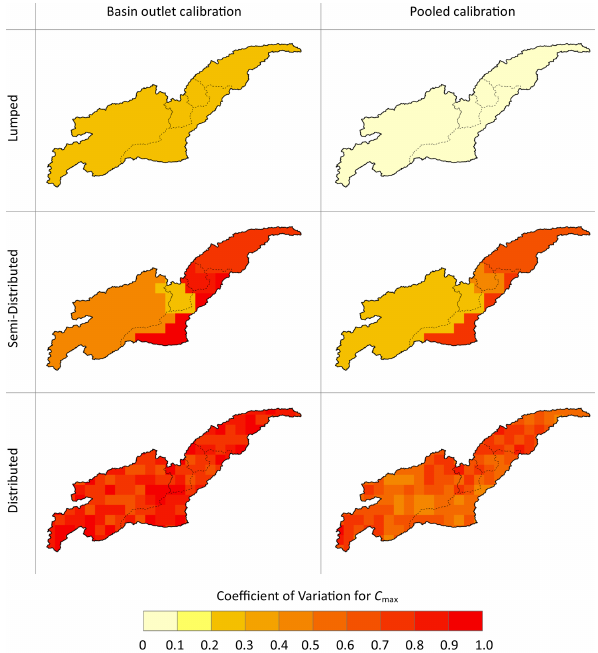
Figure 9. Coefficient of variation (CV) of 50 optimal values of C max (parameter for the soil moisture accounting module in the HYMOD_DS) from the basin outlet calibrations (left panel) and the pooled calibrations (right